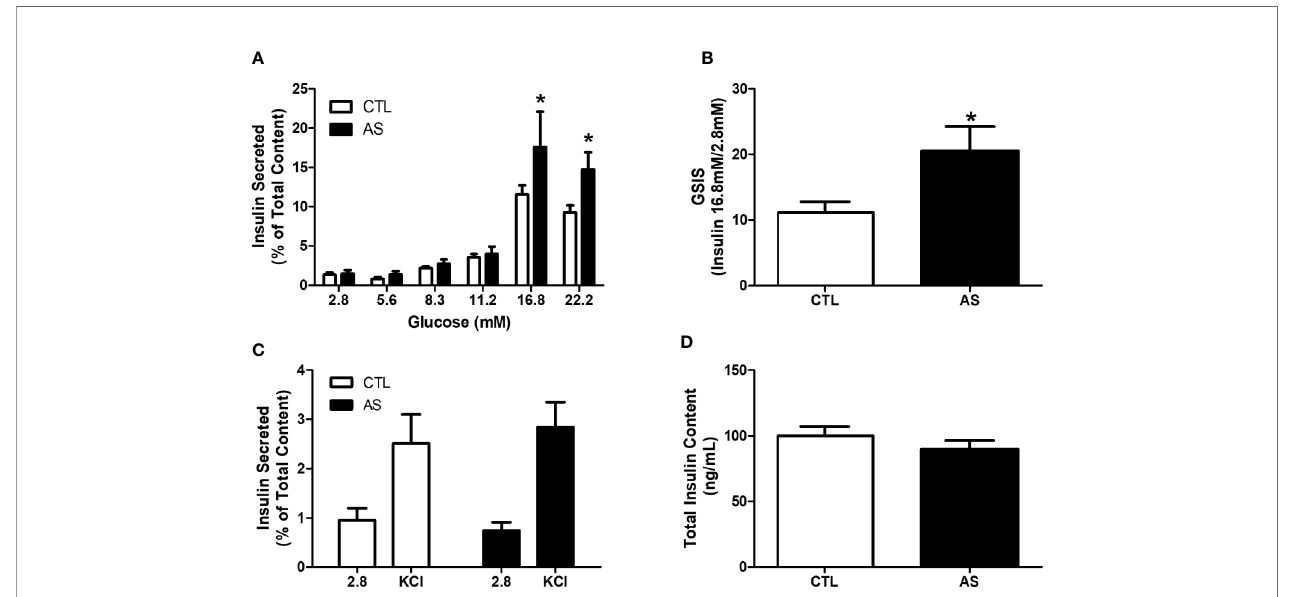
FIGURE 3 | ARHGAP21 knockdown effects on glucose and KCl-stimulated insulin secretion and total insulin content. Adult mice received intraperitoneal administrations of antisense anti-ARHGAP21 for three consecutive days, and pancreatic islets were isolated 24 h after the last administration. (A) Insulin secreted after 1 h incubation with 2.8, 5.6, 11.2, 16.8, and 22.2 mM of glucose. (B) The ratio of insulin secreted between 2.8 and 16.8 mM glucose. (C) Insulin secreted after 1 h incubation with 2.8 mM of glucose and 30 mM of KCl. (D) Total insulin content of pancreatic islets. n = 7 – 8. Data are presented as the mean ± SEM. *P ≤ 0.05